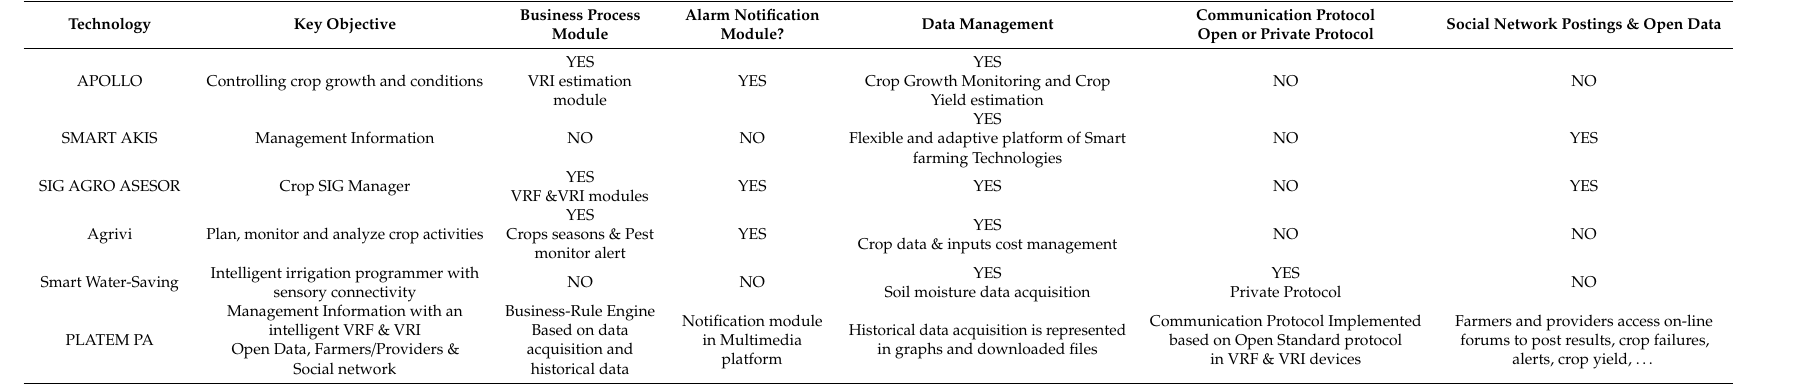
Table 1. Smart farming platforms